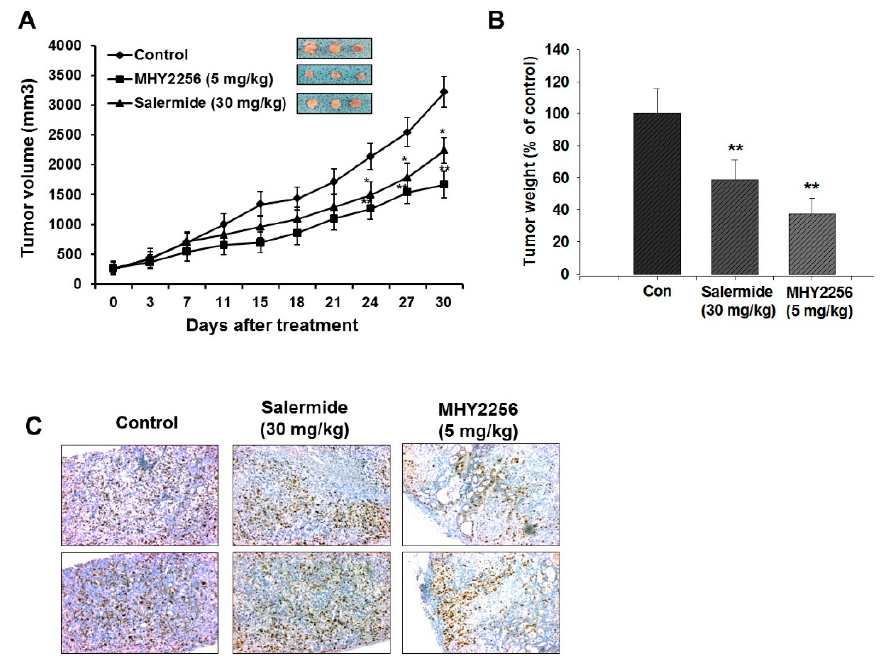
Figure 4. MHY2256 significantly reduces the growth of Ishikawa endometrial cancer cells in nude mice. Mice with pre-established tumors were randomized into three groups, with five mice in each group. The vehicle control, MHY2256 (5 mg/kg, twice/week, intrperitoneal (i.p.) injection), and salermide (30 mg/kg/week, i.p.) were administered to the tumor-bearing mice. ( A ) The mean tumor volumes during the 30-day treatment for each treatment group. ( B ) Each bar represents the inhibition rate (% of control) of the mean tumor weight. ( C ) The tumors were fixed in 10% formalin and embedded in paraffin. Immunohistochemical staining for Ki-67 was measured in the tumors. Magnification = × 200. Scale bar = 50 µ M. The representative images were recorded under a 40 × objective lens. In all graphs, the results are presented as the mean ± SE per group. Statistical analysis was performed using one-way analysis of the variance (ANOVA), followed by Bonferroni’s multiple comparison test. * p < 0.05 and ** p < 0.01 indicate significant differences between the control and treatment